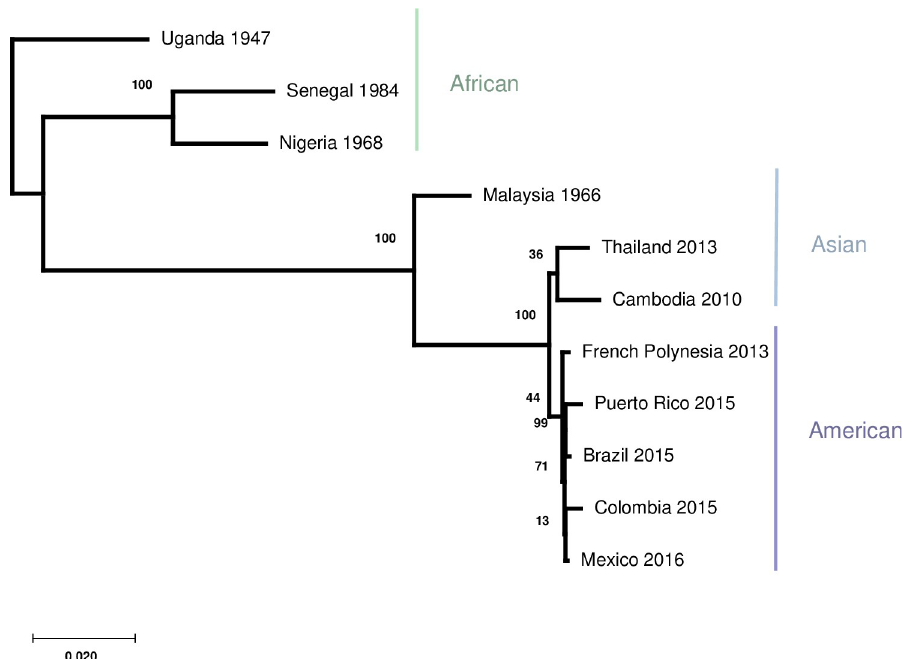
Fig 1. Molecular phylogenetic analysis by maximum likelihood method. The percentage of trees in which the associated taxa clustered together is shown next to the branches. The tree is drawn to scale, with branch lengths measured in the number of substitutions per site. Colored bars correspond to virus strain region of